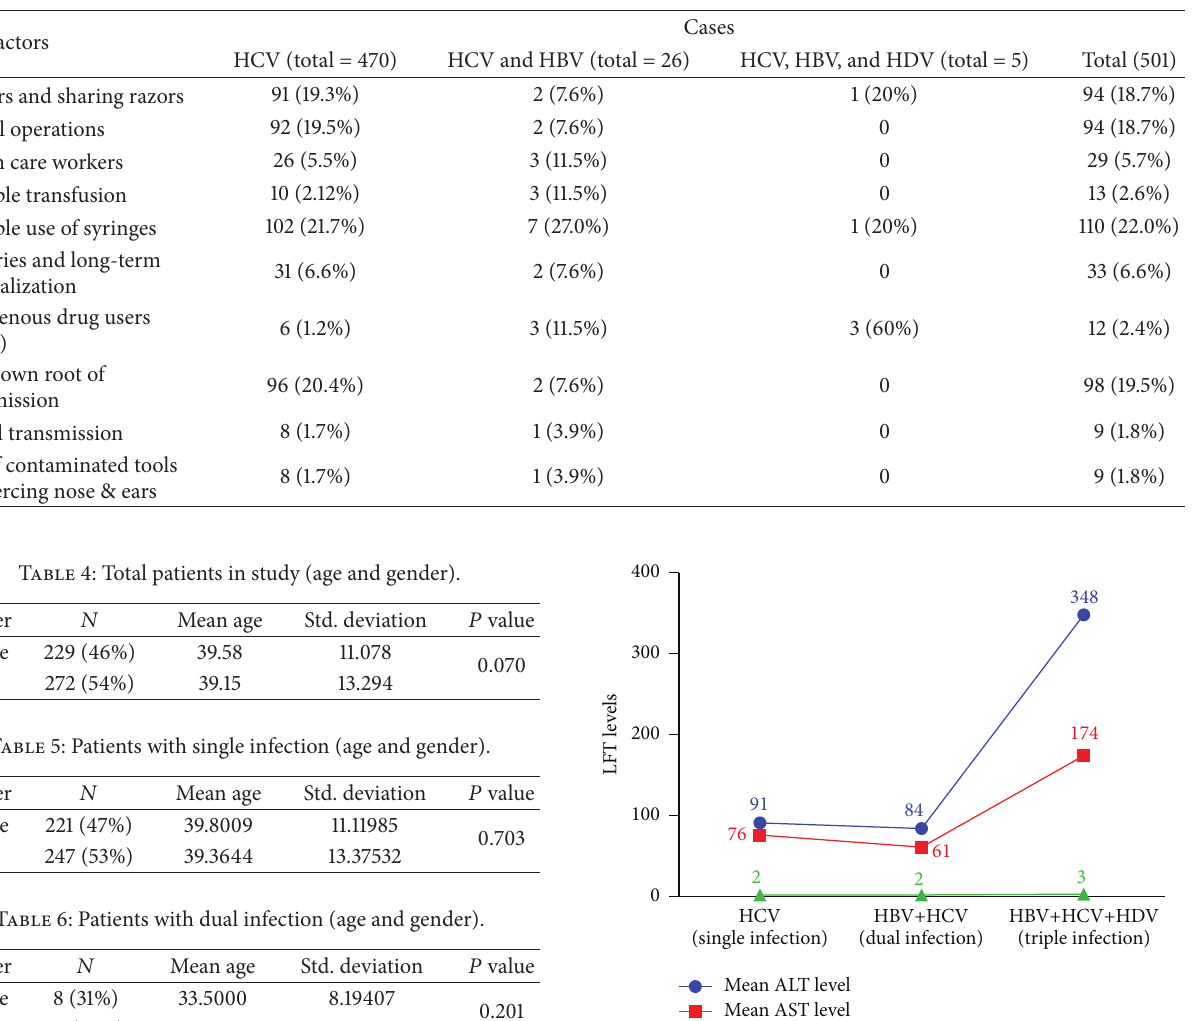
Table 3: Possible associated risk factors for infection transmission.